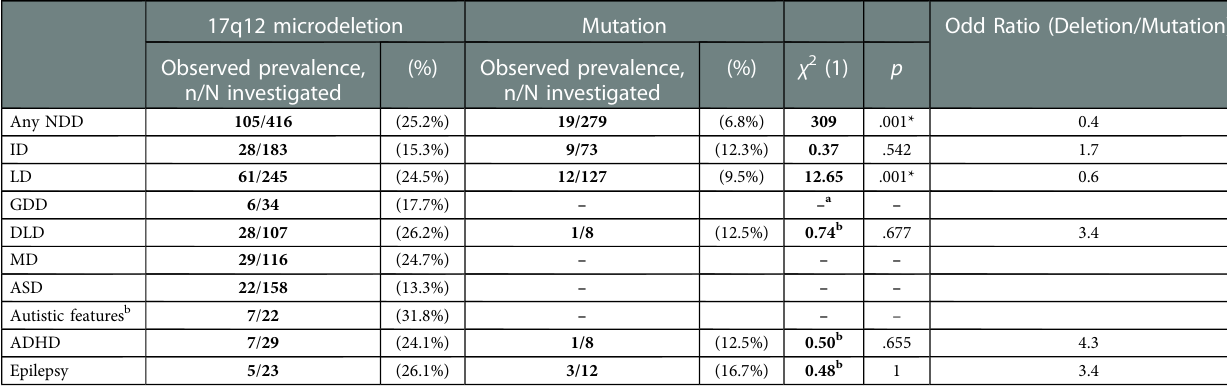
TABLE 2 Types of NDDs in patients with a 17q12 microdeletion or mutation of HNF1B.